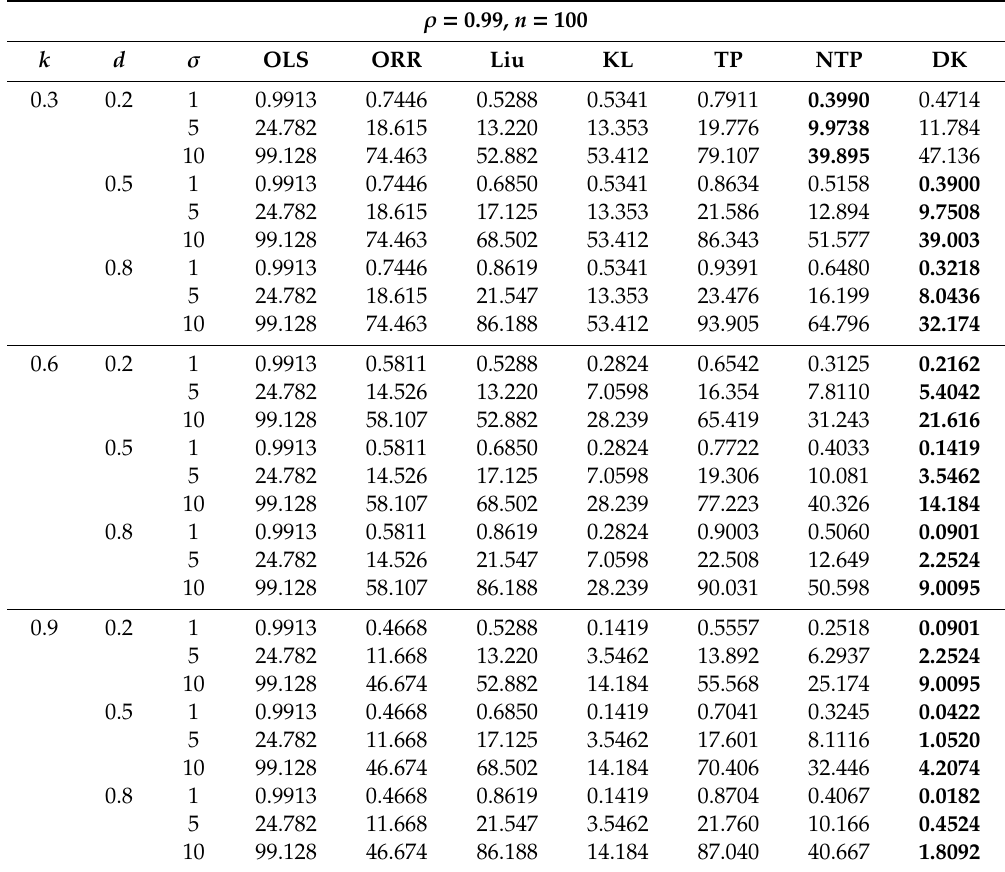
Figure 1. MSE values versus ρ